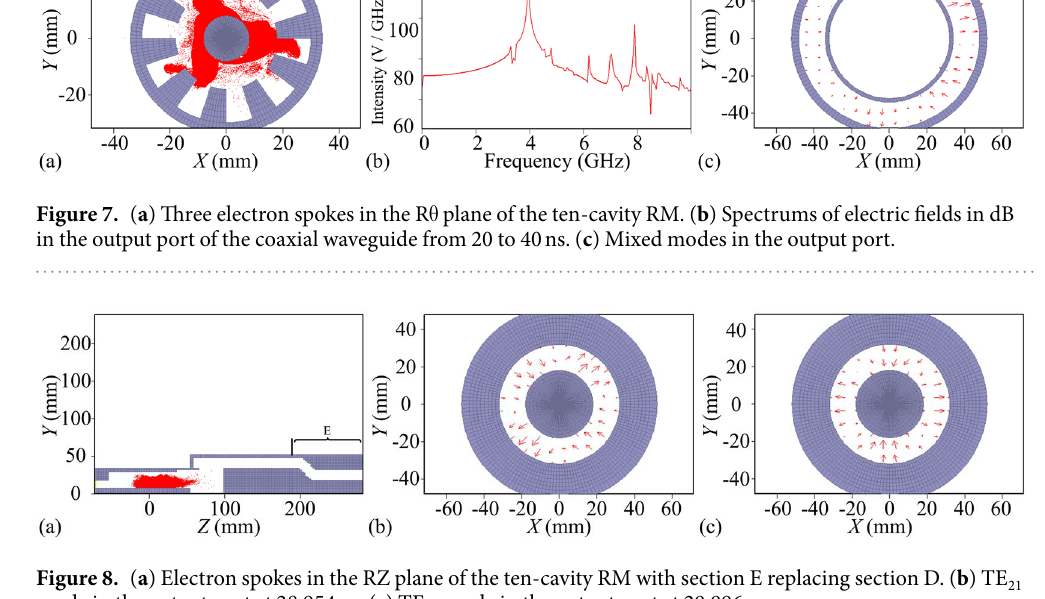
generating the TEM mode, the linearly polarized TE n1 mode, and the circularly polarized TE n1 mode in the coax- ial waveguide are obtained respectively, as well as some regular characteristics of the corresponding mode excita- tion, and then verified by the cold and hot simulations. Undoubtedly, these theoretical investigations provide a comprehensively and thoroughly theoretical guidance for designing this type of RM. And more importantly, they not only show that the RM has the ability of generating any a mode among the TEM mode, the linearly polarized TE n1 mode, and the circularly polarized TE n1 mode in the coaxial waveguide, but also indicate that the direction of rotation of the circularly polarized mode can be easily reversed with the reversion of the direction of rotation of the electron spokes by reversing the current of the magnetic coils. Such unique attractive properties make it possible for this type of RM to meet application requirements of various HPM modes.